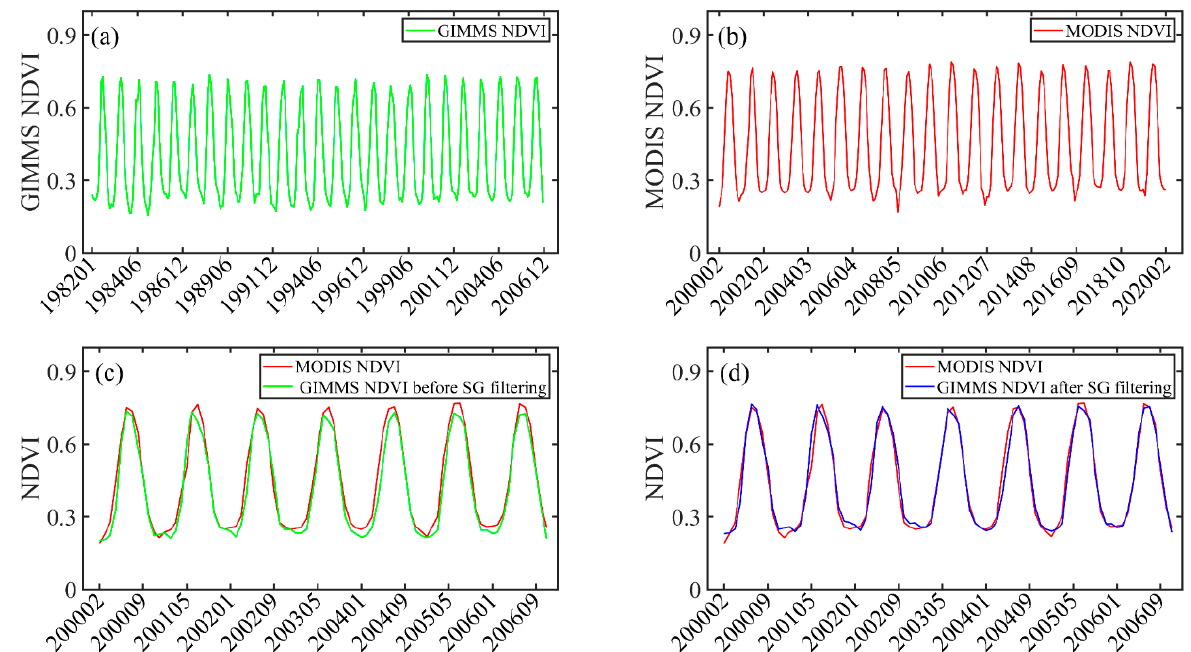
Figure 3. Original sequence of the GIMMS and MODIS NDVI and comparison of the GIMMS NDVI before and after the SG filtering correction. Note: ( a ) represents the original sequence of the GIMMS NDVI; ( b ) represents the original sequence of the MODIS NDVI; ( c ) is the comparison of the GIMMS NDVI before the SG filtering correction and the MODIS NDVI; ( d ) is the comparison of the GIMMS NDVI after the SG filtering correction and the MODIS NDVI. The axis of each subfigure represents the year with the corresponding month.